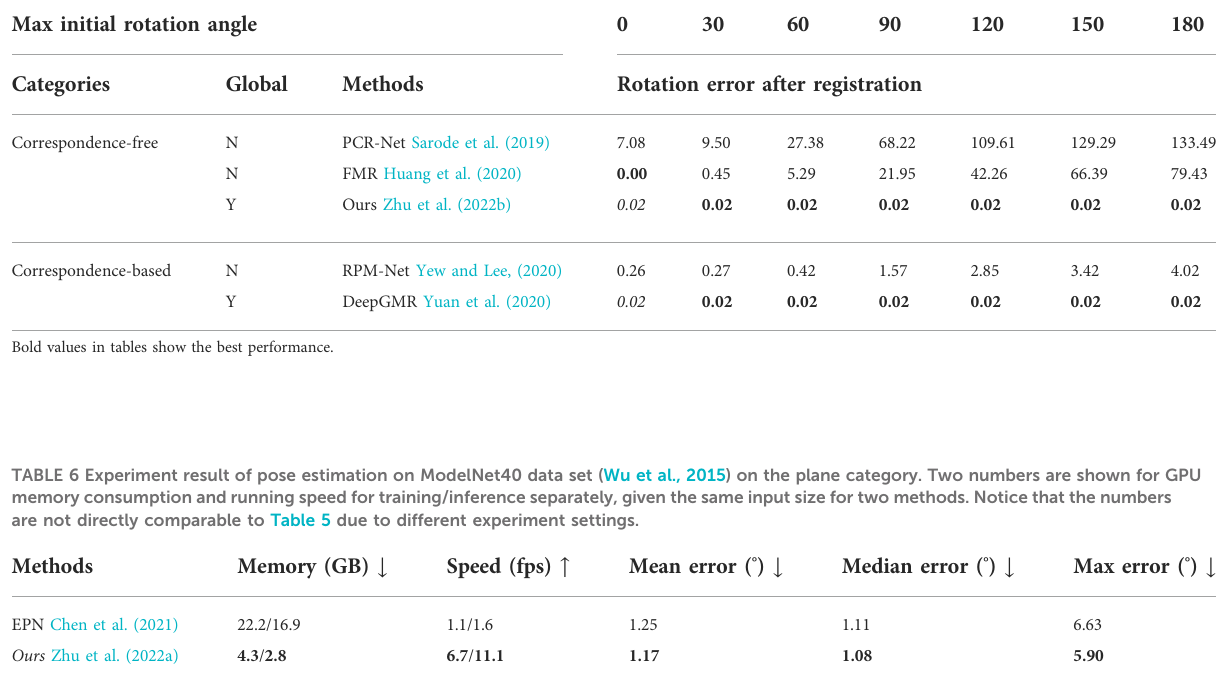
Bold values in tables show the best